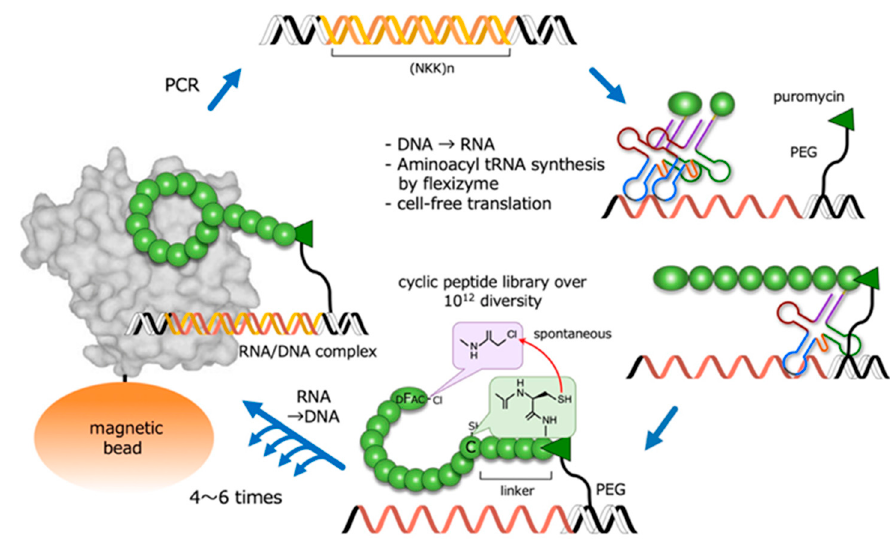
Figure 2. Outline of the RaPID system for the highly efficient screening of macrocyclic peptides from a library with a diversity of over 10 12 structures. PEG: polyethylene glycol; DFac-Cl: D-chloroacetyl phenylalanine.